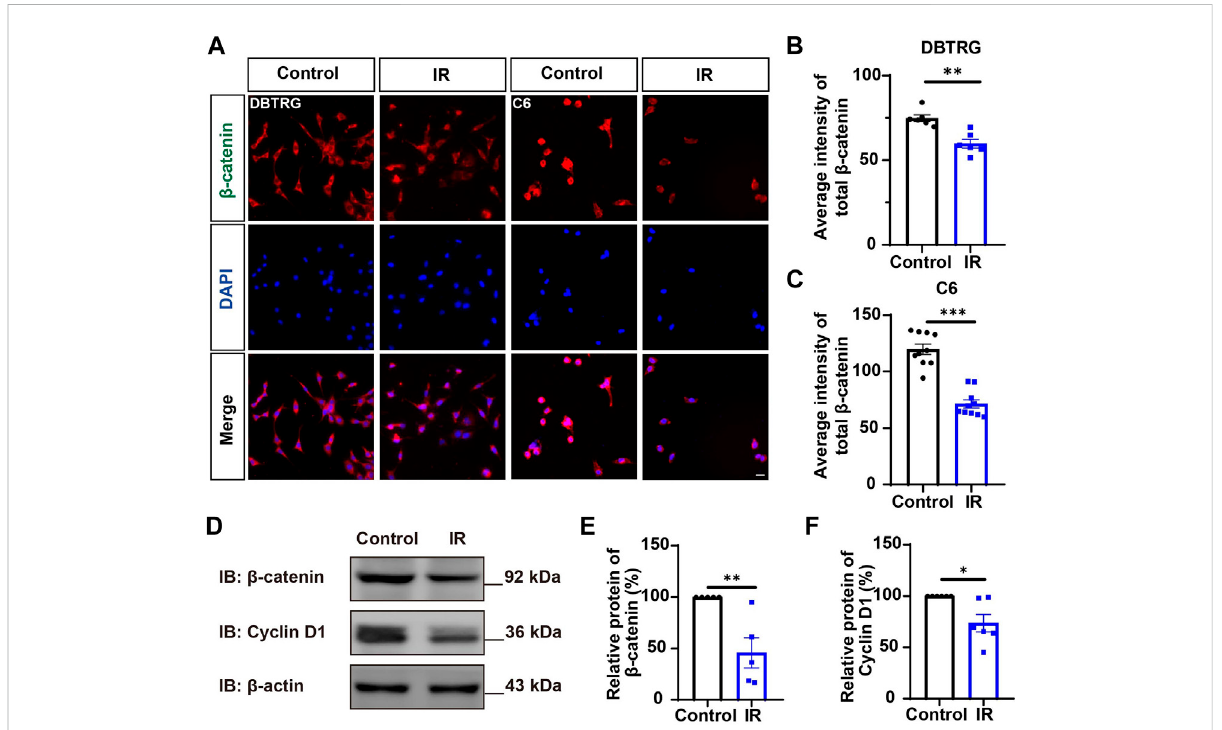
FIGURE 6 Irigenin downregulated the β -catenin signaling pathway in GBM cells. (A) Immunostaining of β -catenin in DBTRG and C6 cells treated with 40 μ M IR. (B – C) Quanti fi cation of the intensity of β -catenin in DBTRG cells (B) and C6 cells (C) as shown in (A) ( n = 10, per group). (D) Western blot detected the expression of β -catenin and Cyclin D1 in DBTRG cells treated with 50 μ M IR. (E – F) Quanti fi cation of the relative level of β -catenin (E) , and Cyclin D1 (F) as shown in (D) , ( n =3per group, normalizedto control). Scalebars,20 μ m.Data wereshown asmean ± SEM. *p < 0.05, **p < 0.01, ***p < 0.001, compared with control